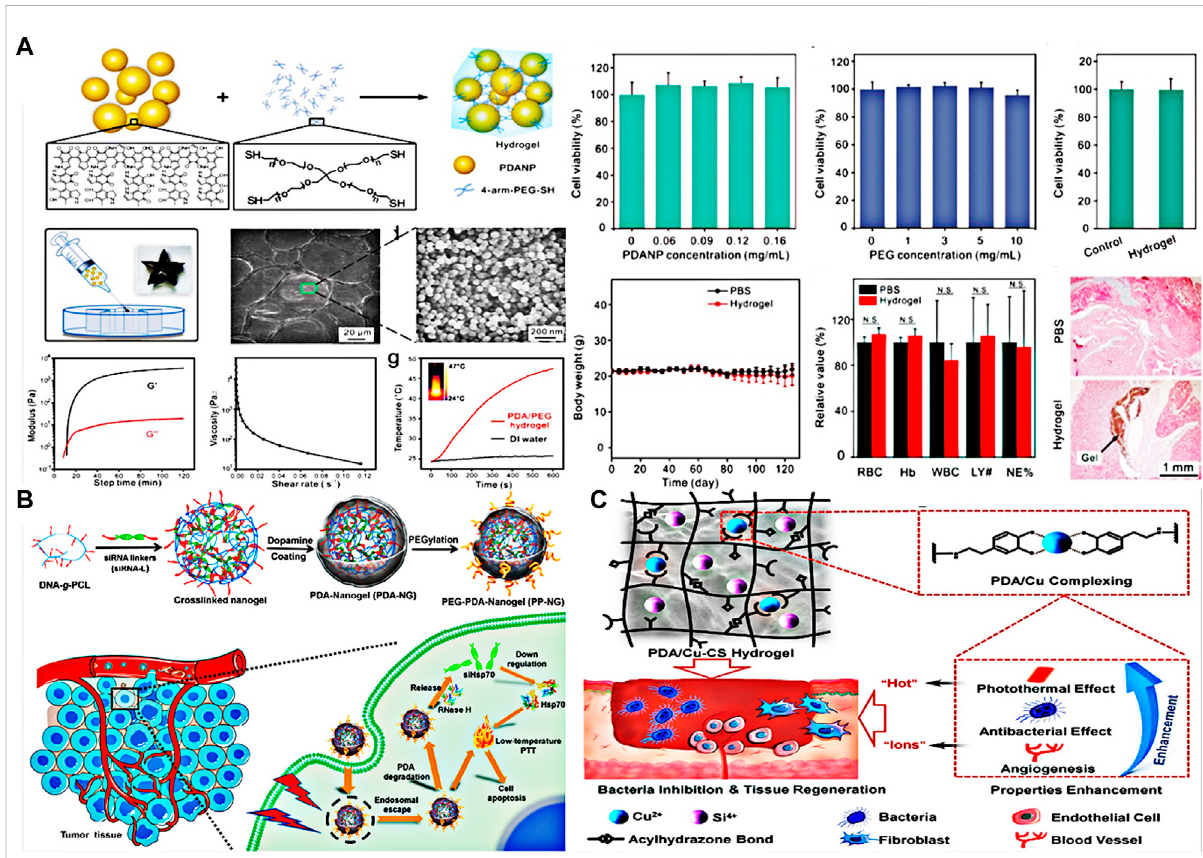
FIGURE 6 (A) Preparation and performance test of PDA-PEG hybrid hydrogels. Reproduced from ref. 80 with permission from 2017, American Chemical Society. (B) Preparation of polydopamine coated nucleic acid hydrogels. Reproduced from ref. 15 with permission from 2020 Elsevier Ltd. (C) Preparation of polydopamine combined Cu-CS hydrogel and its application in antibacterial. Reproduced from ref. 92 with permission from 2020, American Chemical